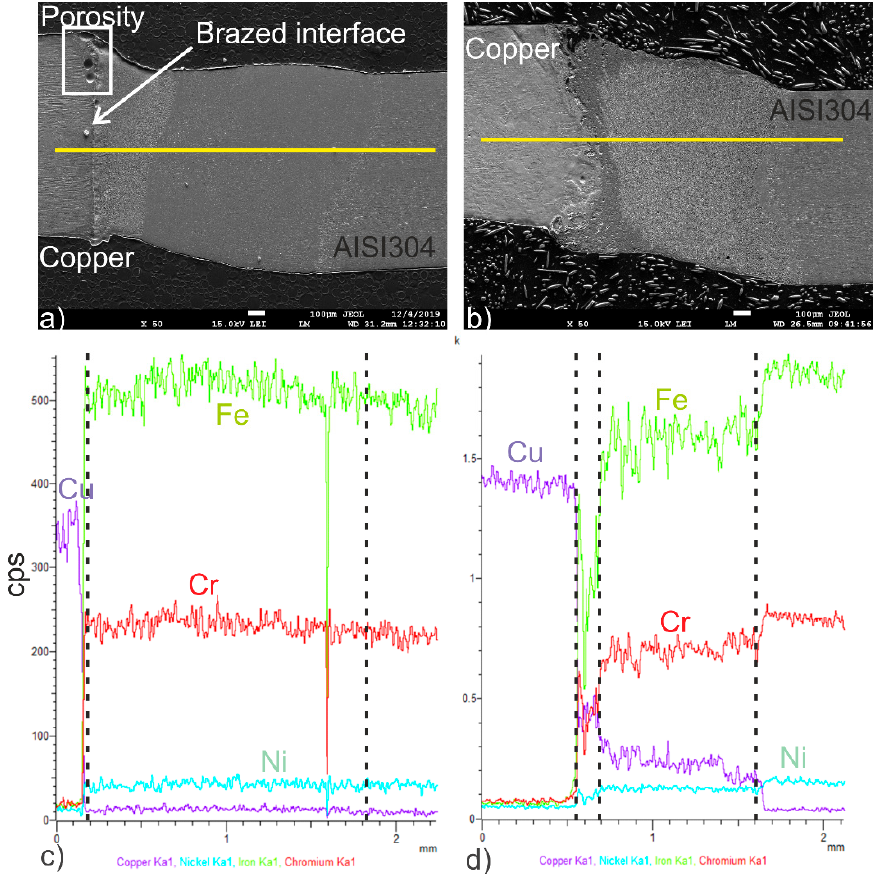
Figure 8. SEM image of area for EDS line analysis of the weld ( a ) No. 1 and ( b ) No. 5, elemental distribution across welded joint ( c ) No. 1 and ( d ) No. 5.